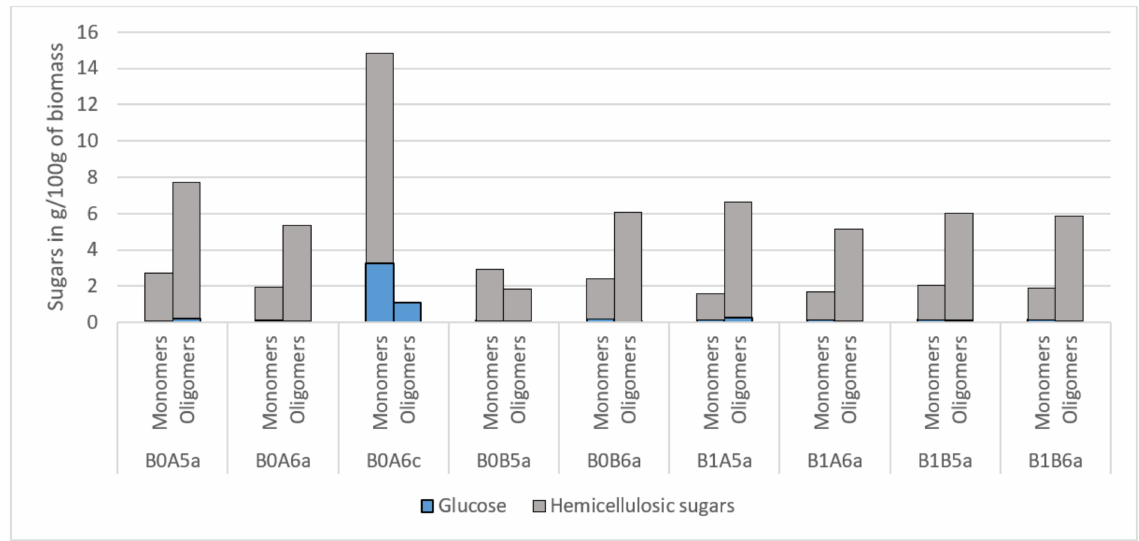
Figure 1. Total sugars (g/100 g of biomass; expressed as monomeric sugars) recovered after each pretreatment condition in the hemicellulose liquid fraction. Representation of the codes: 0—pretreatment at 200 ◦ C; 1—pretreatment at 180 ◦ C; A—pretreatment time of 15 min; B—pretreatment of 30 min; 5—50% v / v ethanol content; 6—60% v / v ethanol content; a—no catalyst added; c—1% w / w biomass H 2 SO 4